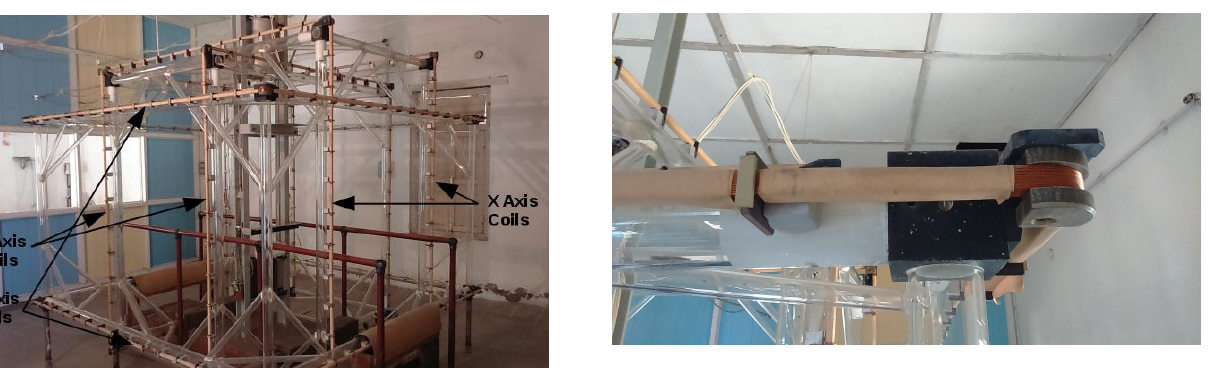
Figure 6. The Bakelite bracket is used to roll the coil at the edges and ensures additional stiffness.